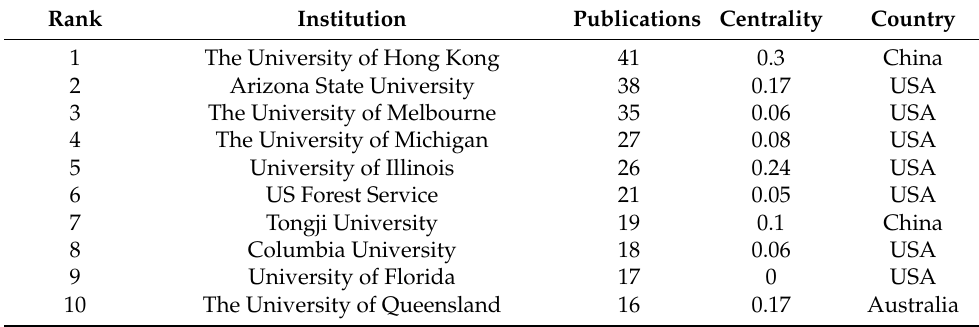
Table 4. Institutions based on publications.